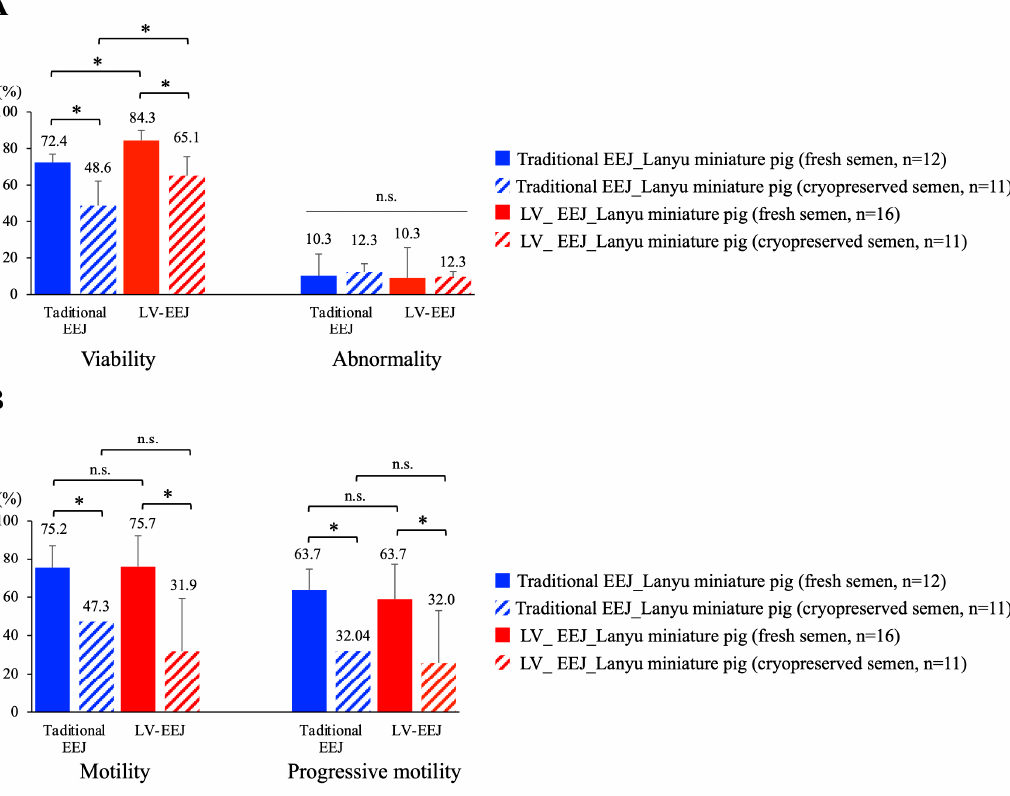
Figure 3. Sperm characterization (I). ( A ) Sperm viability and abnormality were evaluated manually by propidium iodide (PI) staining and standard Papanicolaou (PAP) and POPE’s staining. Clear sperm morphology can be visualized and evaluated under conventional light microscopy; more than 100 sperm cells were examined in each experimental collection. ( B ) Sperm motility and progressive motility were evaluated by computer assisted sperm analyzer (CASA). Statistical difference was set at p < 0.05 and significance was marked with asterisks (*), n.s. = no significant. Data presented as mean ± standard deviation (SD).